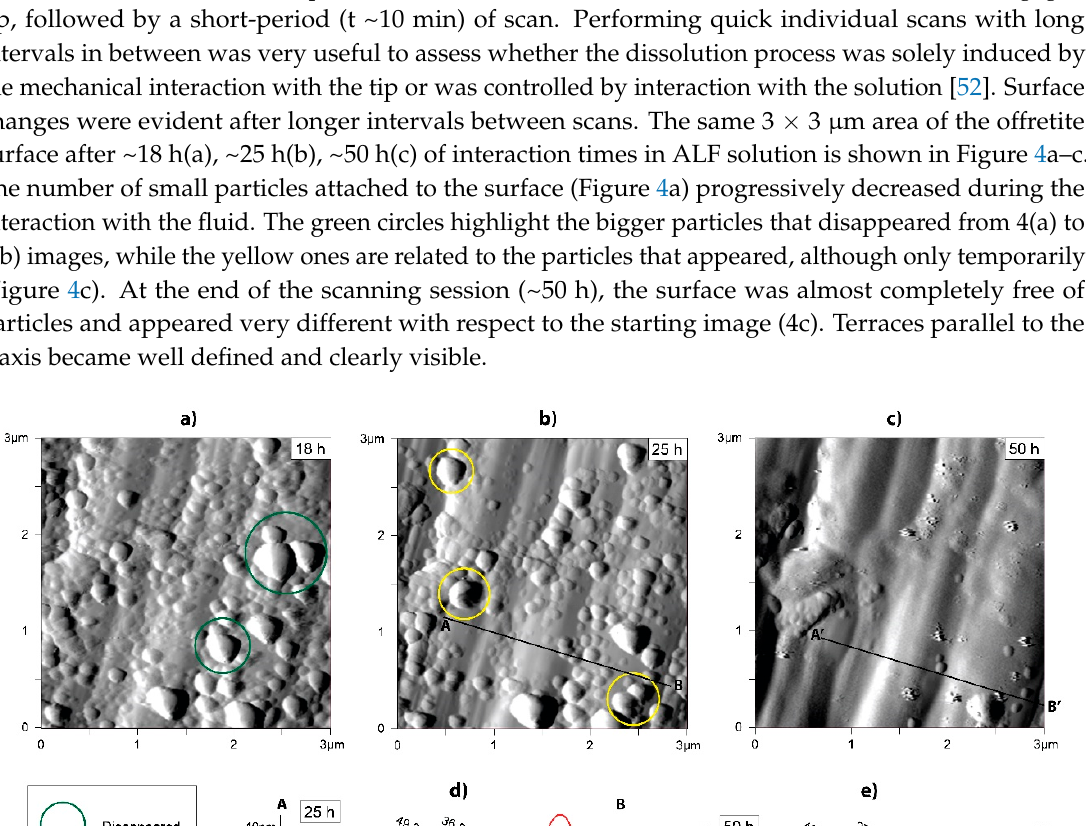
Figure 5. Sequence of amplitude retrace AFM images of the same surface area of FF surface at 37 °C ( a ) in water and at different time of interaction in ALF solution (pH 4.34): ( b ) 1 h; ( c ) 8 h. From the images and related sections ( d ) and ( e ) the surface dissolution and particles removal is notable. Gamble’s experiments on FF sample were also conducted at two different temperatures, 37 °C and 25 °C.